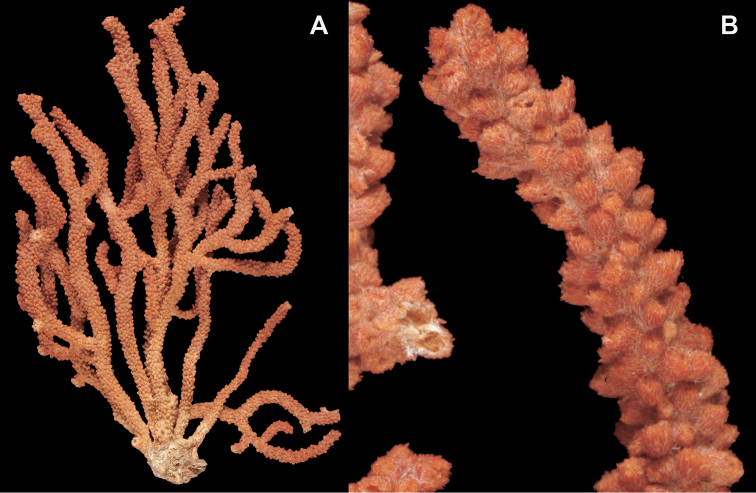
Muriceafruticosa, SBMNH 422430 (as seen in California waters). Colony shows pale base area tending to darker, colored branch tips. A Whole colony, 15 cm tall × 11.0–11.5 cm broad B Closer view of branch tip showing conical calyces forming shelf-like projections off branch surface.